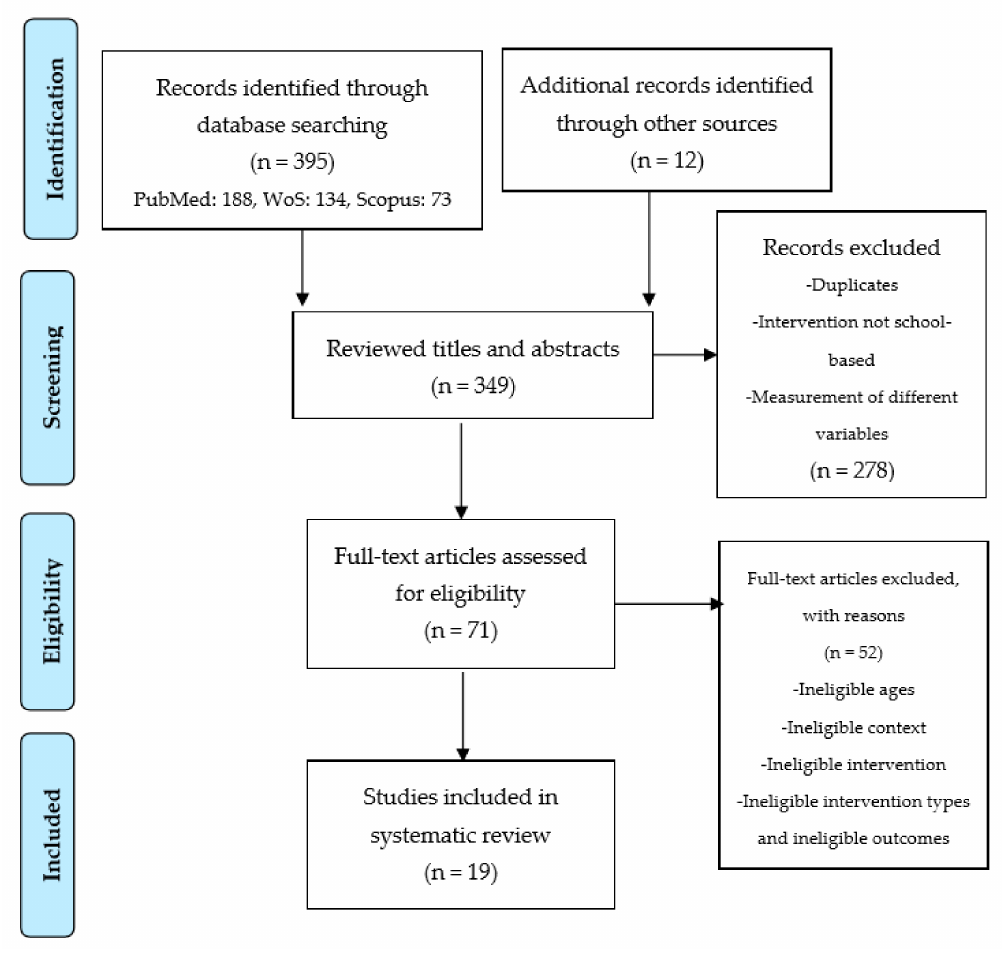
Figure 2. Flow diagram of studies through the review